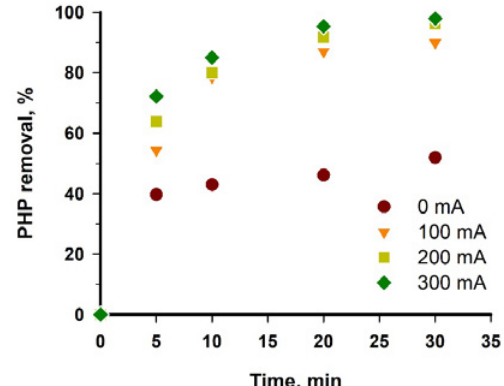
Fig. 5. PHP removal efficiency of the HSEF at different pH levels. Reaction conditions: 0.1Fe-ZSM-5 concentration of 0.2 gL -1 , applied current of 100 mA, ultrasonic power of 600 WL -1 .